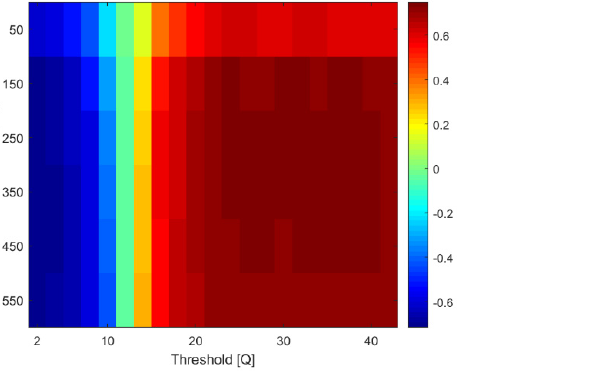
Figure 8. RMSE ( left ) and cross-correlation ( right ) for SSC with different thresholds (Q multipliers of MAV at rest) and window widths (actual value of Q is shown/10). Finding: with threshold = 2 × MAV (rest) the window can be short (150–250 ms).